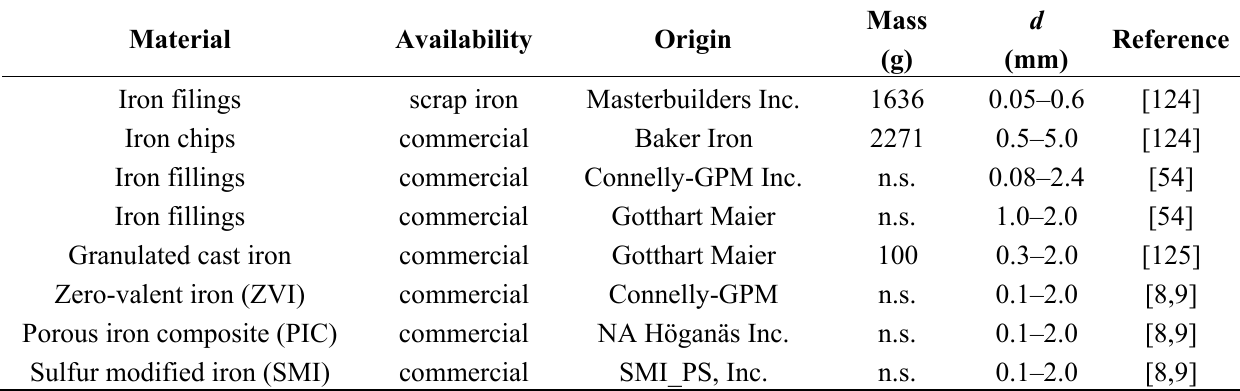
Table 2. Selected characteristic of Fe 0 -based filter materials used in studies presented as examples in §